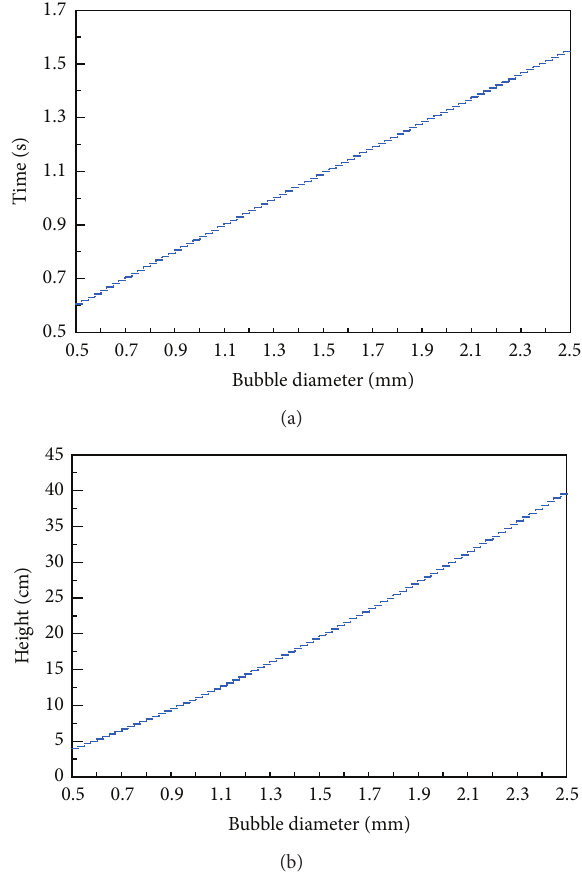
Figure 6: Time and column height needed for relative methane concentration reaching 𝑐 𝑔 = 99 %, in the function of diameter 𝐷 𝑔 .